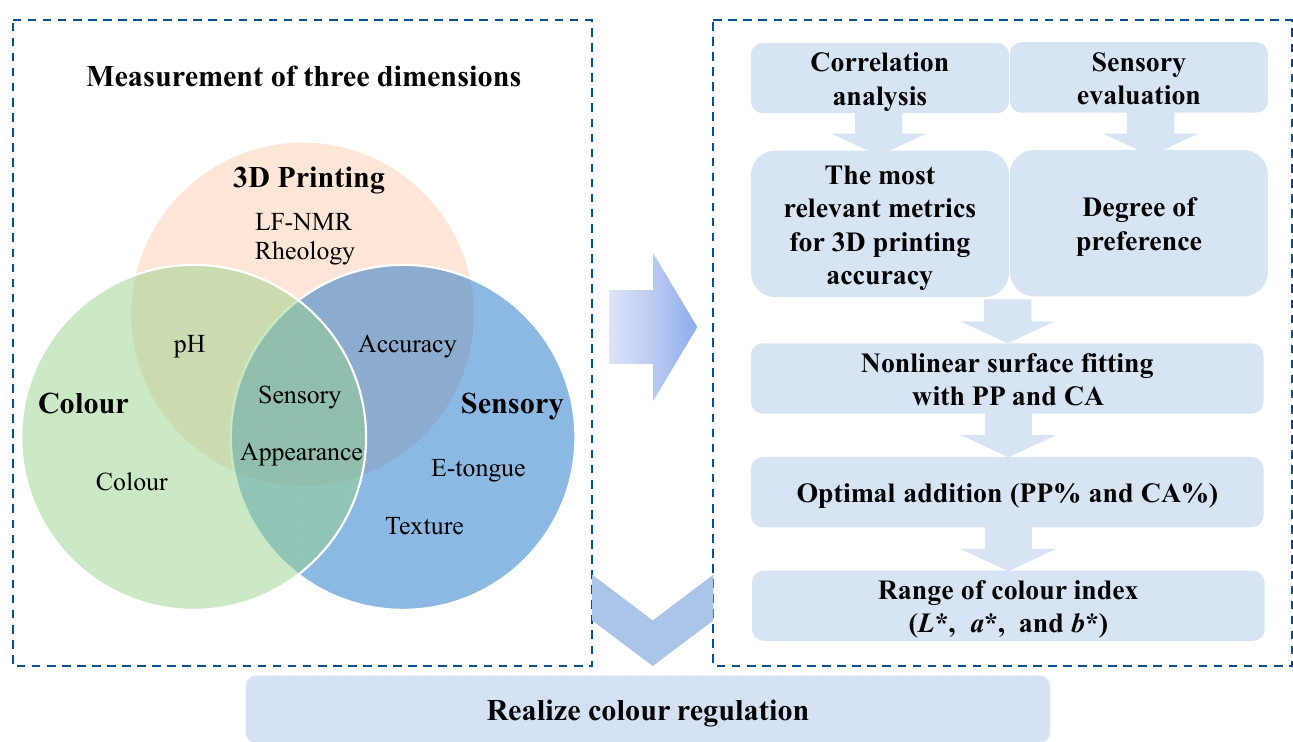
Figure 1. Experimental considerations.